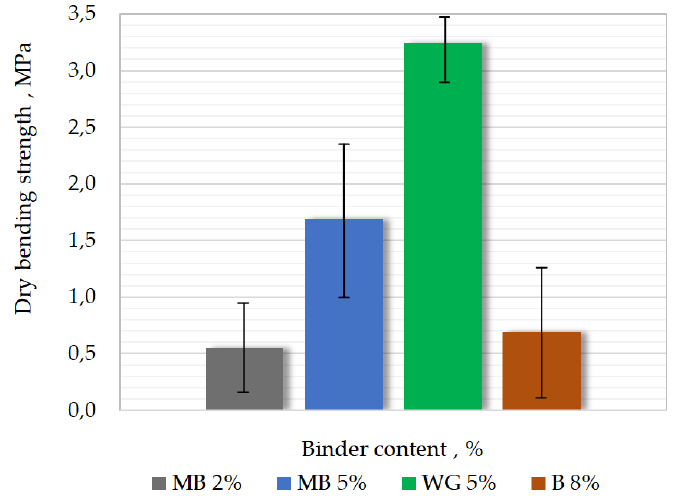
Figure 10. Results of dry bending strength measurements of different molding sands.